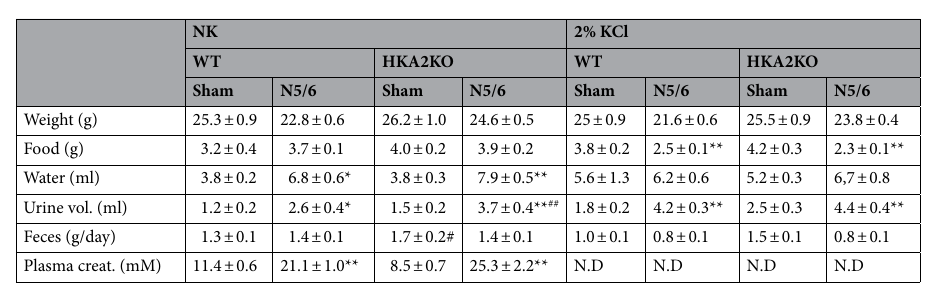
Table 1. Physiological parameters of WT or HKA2KO mice, sham or nephrectomised (N5/6) under normal (NK) or high potassium (2% KCl) diet for 24 h. Results are shown as mean ± s.e.m. Two-way ANOVA